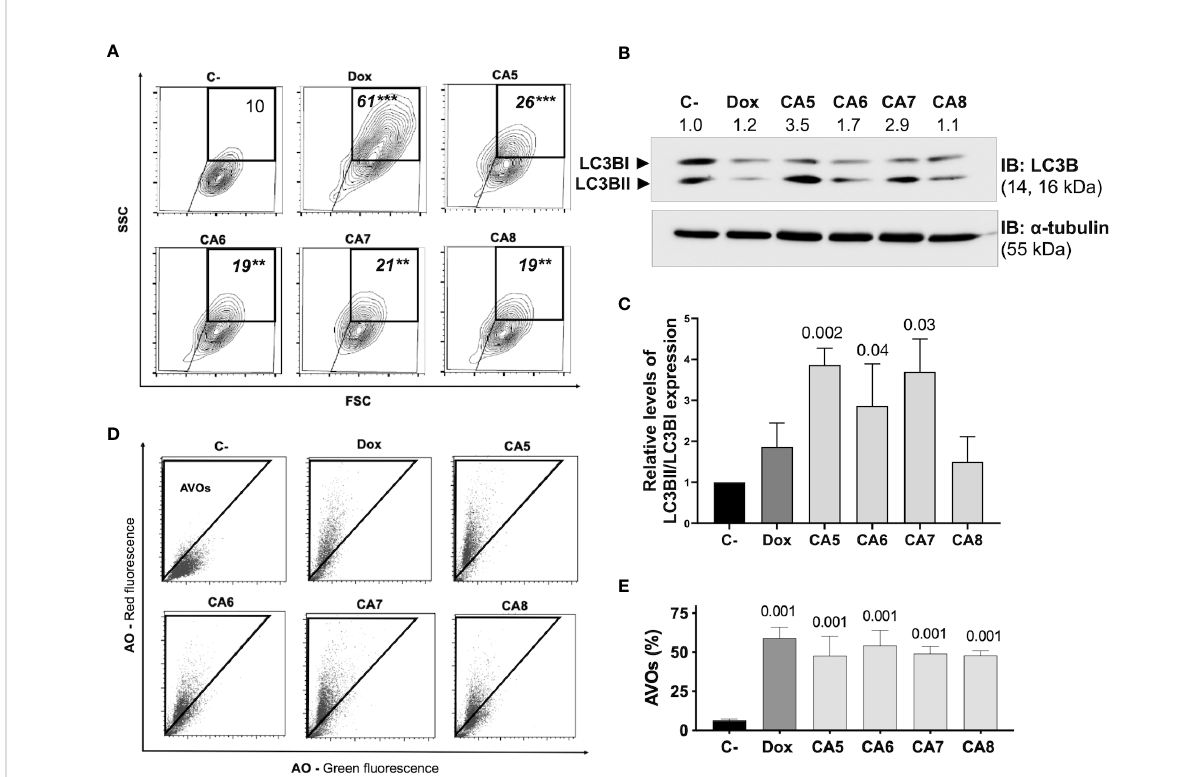
FIGURE 3 Chromomycins A 5-8 induce autophagy. B16-F10 melanoma cells were treated with DMSO (C-), as a negative control, doxorubicin (Dox), as a positive control, and CA 5-8 (CA5-8) for 24 h. (A) Representative contour plot graphs of cells with granularity gated on high side scatter (SSC) and average forward scatter (FSC) region by fl ow cytometry and (B) Expression of LC3BII and LC3BI obtained by Western blot and (C) , column graph of Western blot analysis. (D) , Representative dot plots of acridine orange (AO) staining. Acidic vesicular organelles (AVOs) were gated on the region with increased red fl uorescence by fl ow cytometry and (E) the graph showing the percentage of AVOs. Data presented in graphs as mean ± standard deviation of 3 independent experiments. The AVOs detection was performed in triplicate. The p values of C- compared to the treated groups are above each treated group. **p=0.01 and